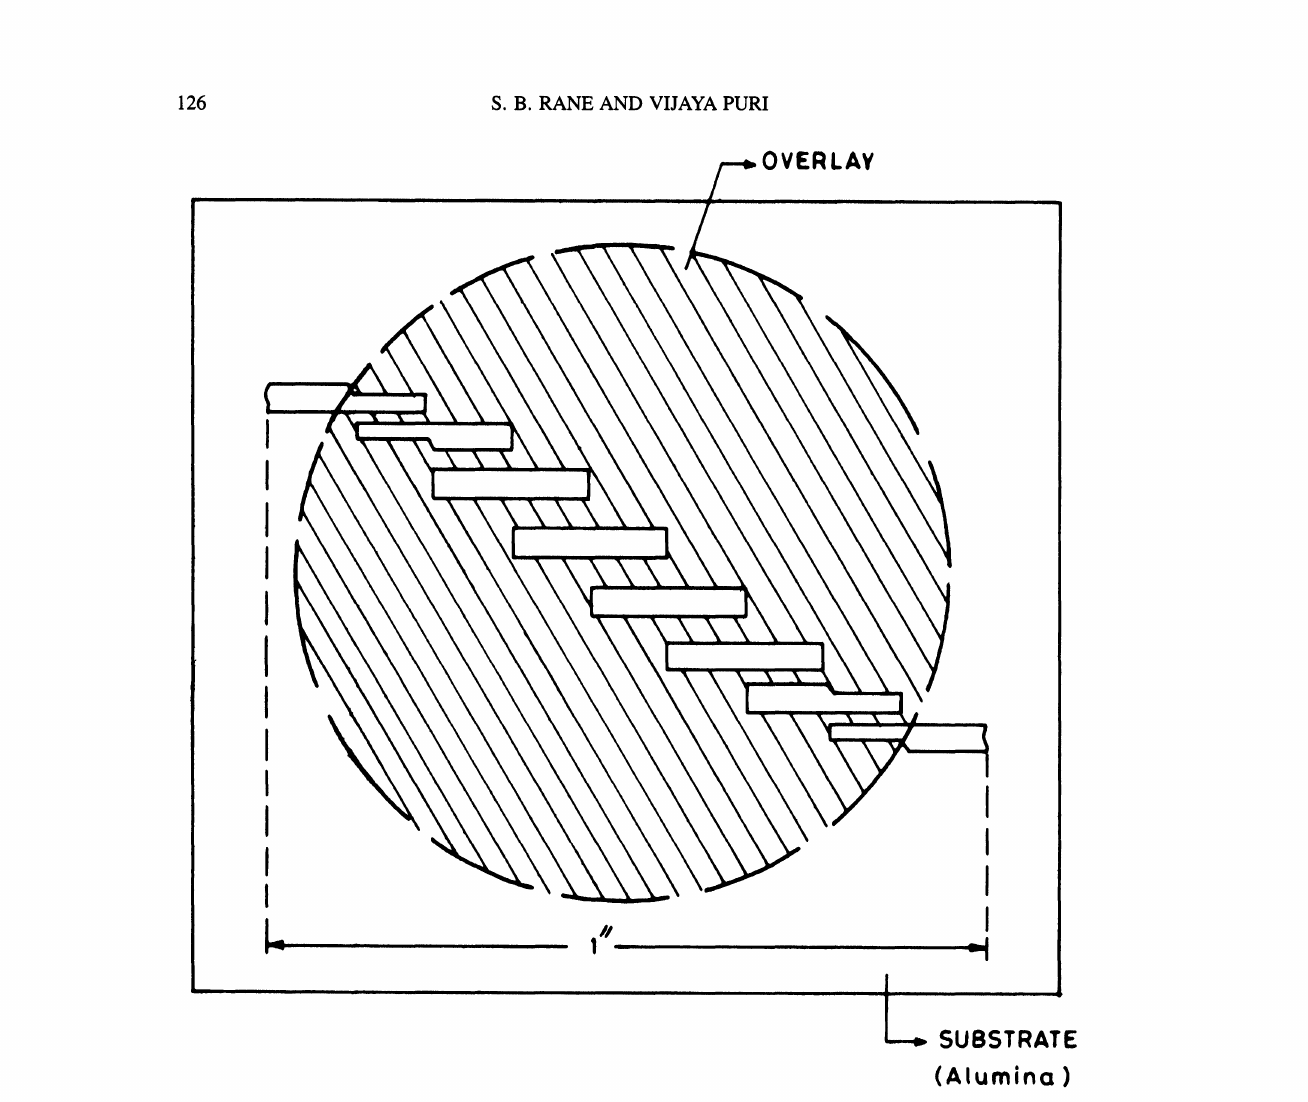
FIGURE .Schematic of seven section parallel coupled microstrip band pass